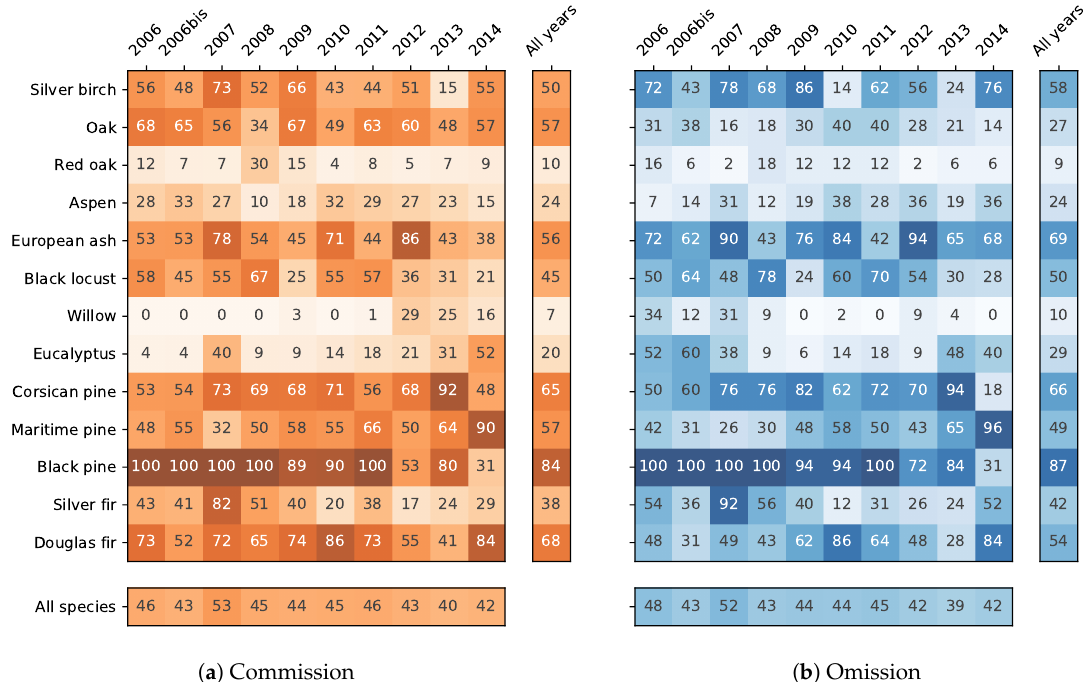
Figure 7. Confusion matrix for 13 tree species for year 2013. Each cell provides an average value of agreement or confusion (in %) based on 50 classifications (number of iterations) using the SLOO-CV sampling strategy.